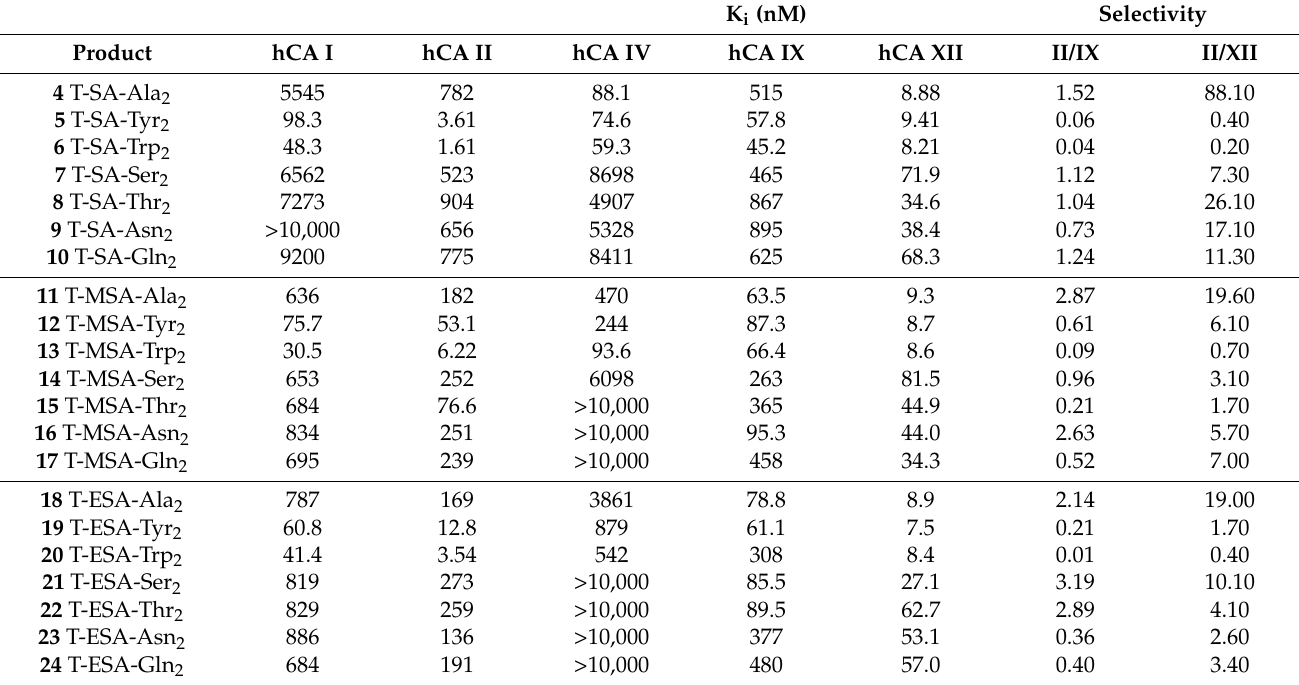
Table 2. Inhibition data for the derivatives 4 – 24 against hCA I, II, IV, IX, XII and their selectivity ratios for tumor-associated